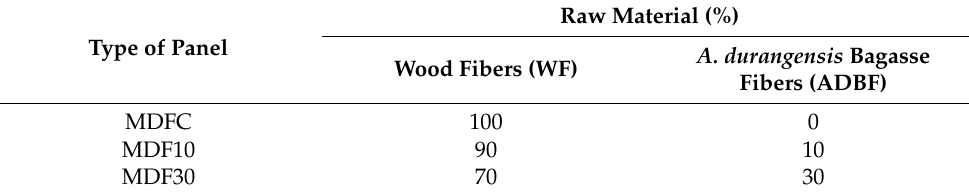
Table 2. Types of panels and their ratios of raw material used.